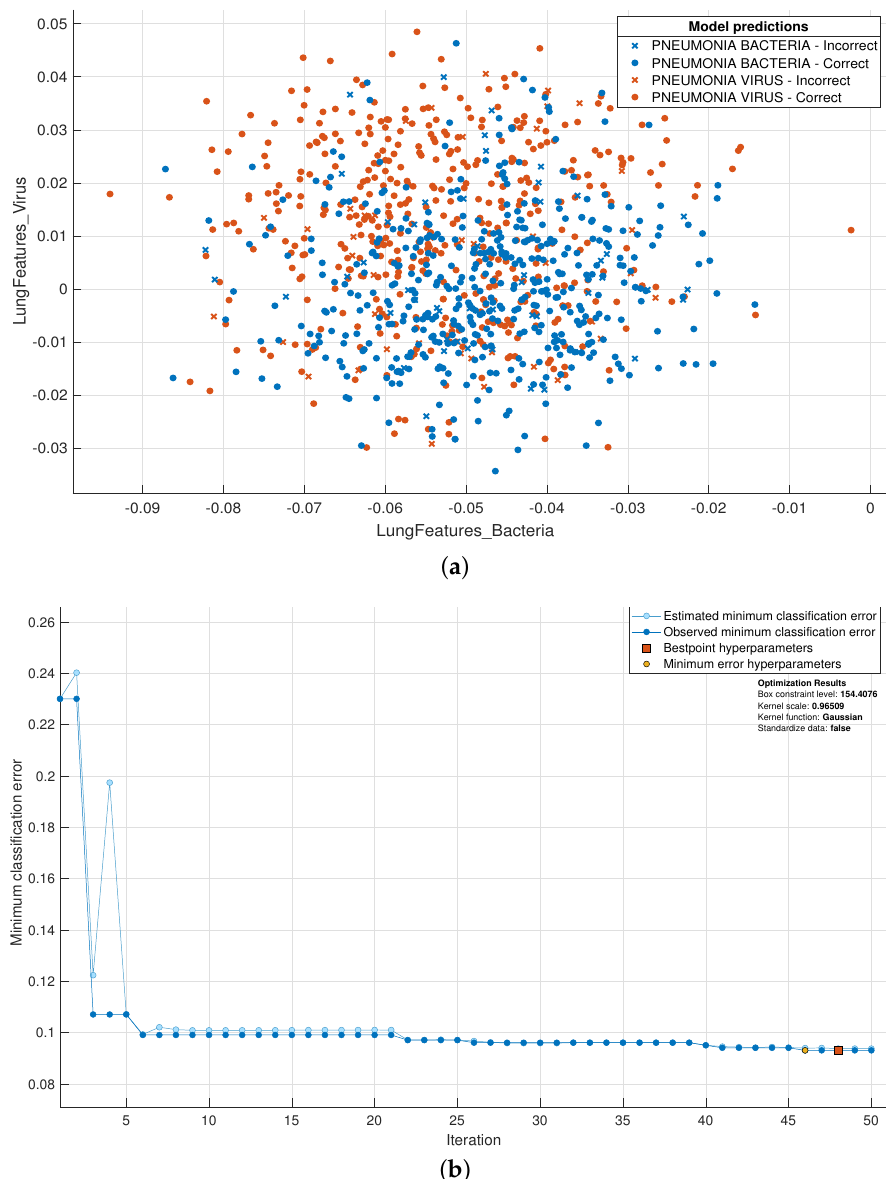
Figure 6. Performance of proposed model using bacterial vs. viral pneumonia scenario. ( a ) is the feature space of bacterial vs. viral infected lung CXR images, and ( b ) is the SVM with Bayesian optimization of the proposed